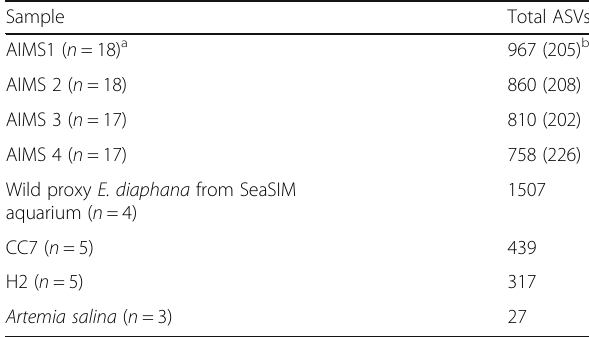
Table 3 Number of bacterial ASVs in each sample type Sample